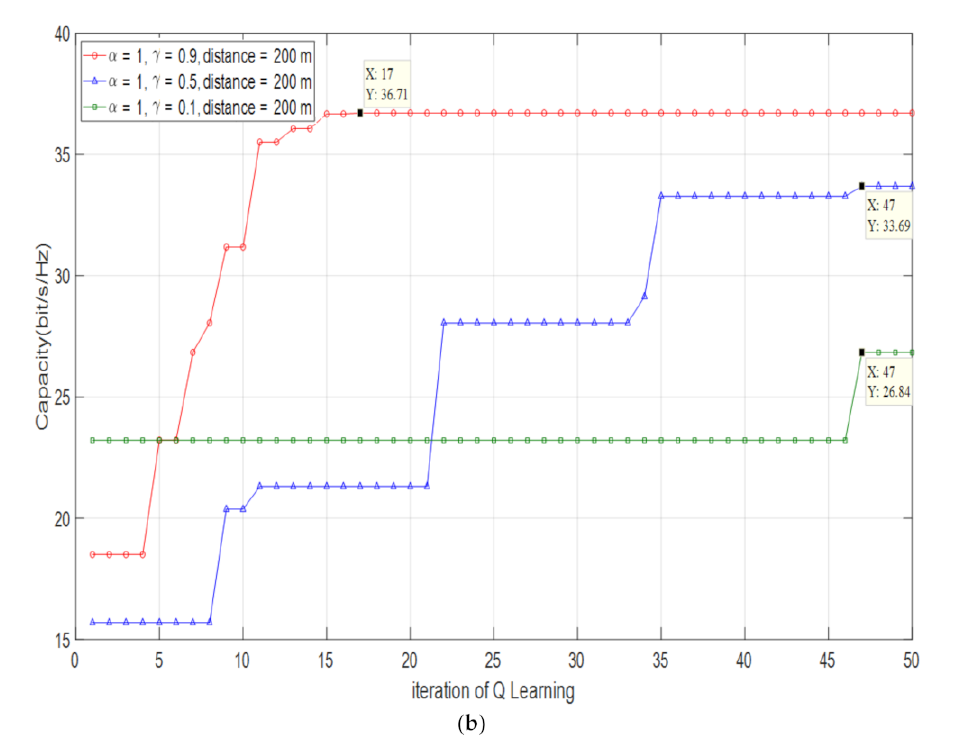
Figure 15. ( a ) Optimized antenna downtilt angle; ( b ) optimized channel capacity. D = 200 m, α = 1 with different γ values.